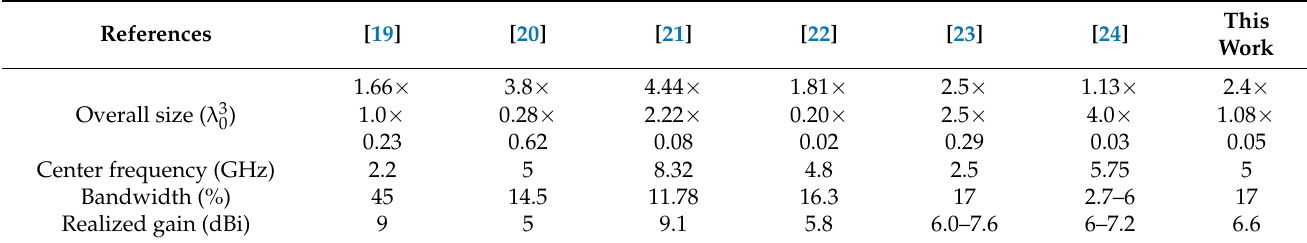
Figure 17. Efficiency of the array antenna. Table 2. Compared results between different types of